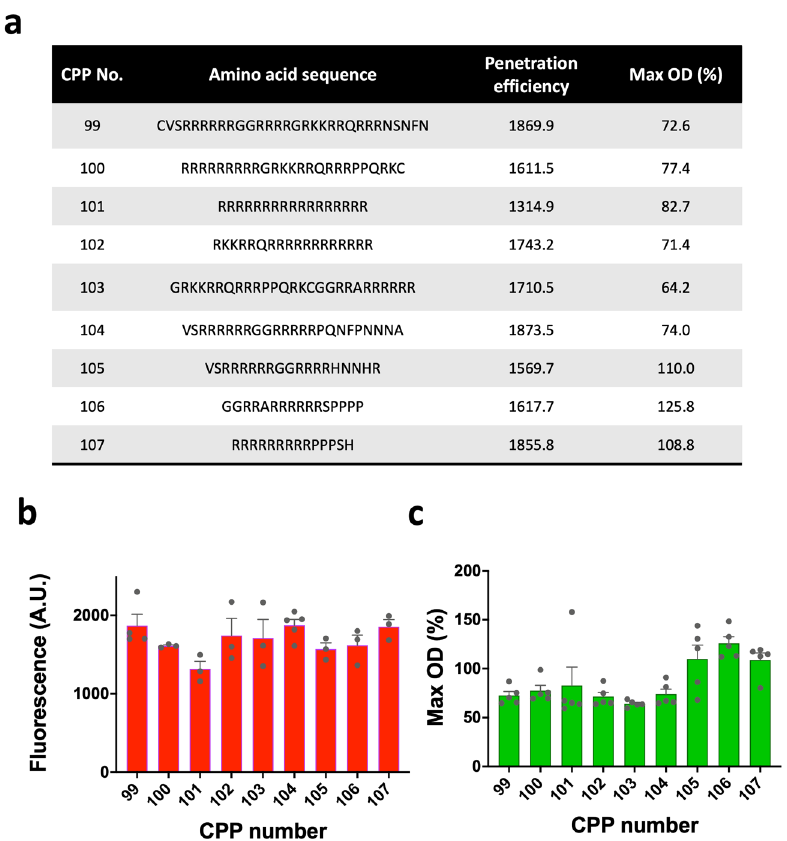
Fig. 5 The nine designed CPP sequences and their penetration ef fi ciency and cytotoxicity. a The list of nine CPP sequences that were predicted by our developed computational model to have highly ef fi cient cell membrane penetration. b, c Evaluated penetration ef fi ciency and cytotoxicity of the TAMRA- labeled CPPs, respectively. Biological replicates ( n ): n = 3 – 5 for penetration ef fi ciency, n = 5 for cytotoxicity. Max OD (%) denotes the maximal OD of CPP- treated cells divided by the maximal OD of non-treated cells, multiplied by 100. The datasets used to draw the graphs are compiled in Supplementary Data